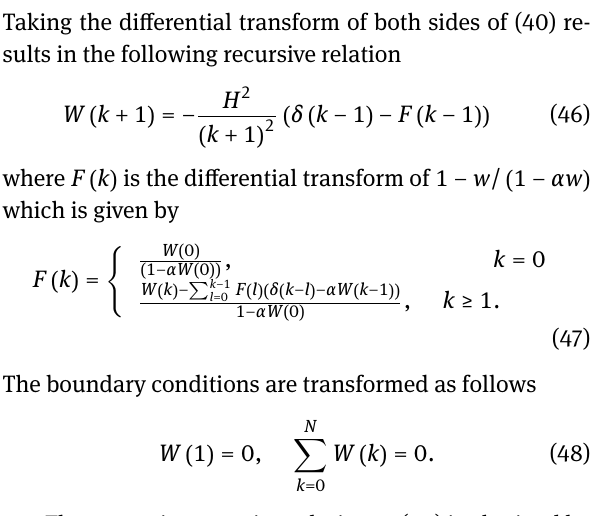
The error remainder function for (40)